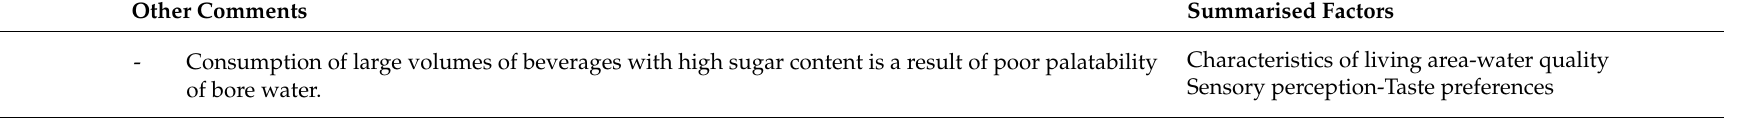
Table 7. Factors influencing SSB consumption extracted from the included quantitative